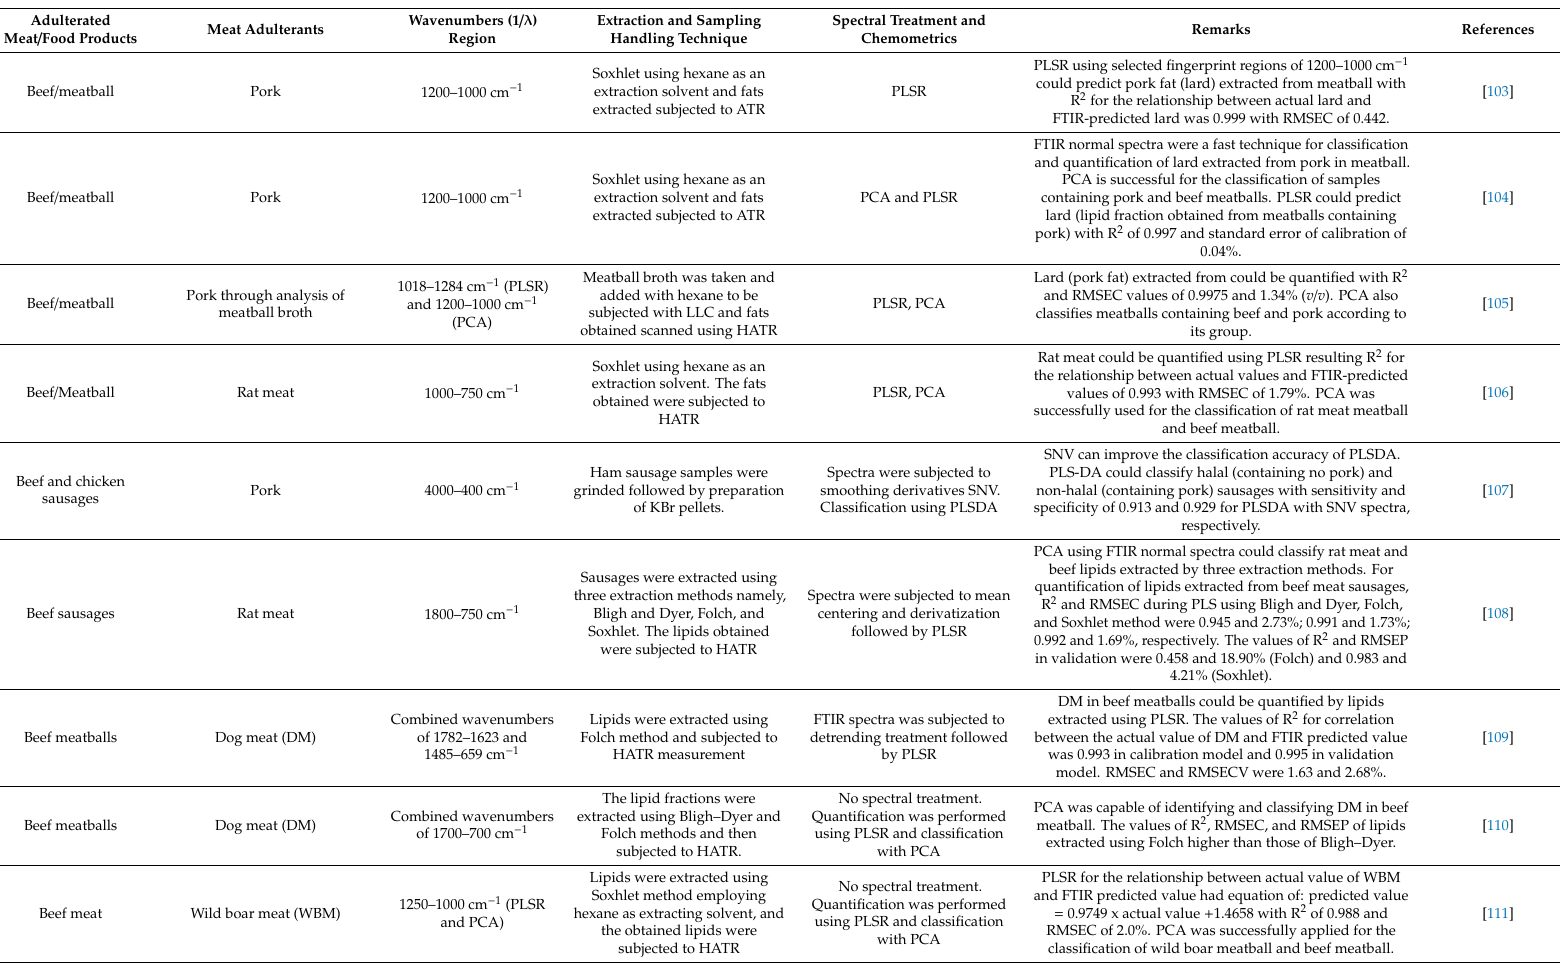
Table 2. The application of FTIR spectroscopy combined with chemometrics for authentication analysis of fats in meat-based food products. Adulterated Meat /